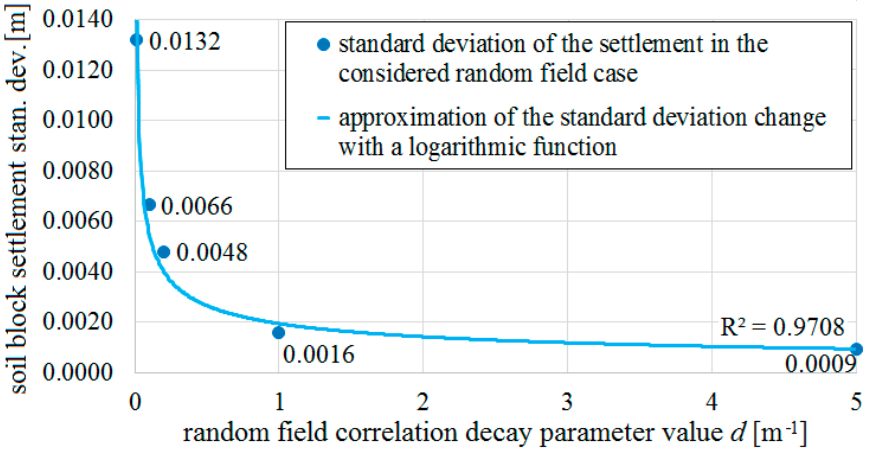
Figure 5. Soil block settlement dispersion versus the correlation decay parameter d ; random field approach.